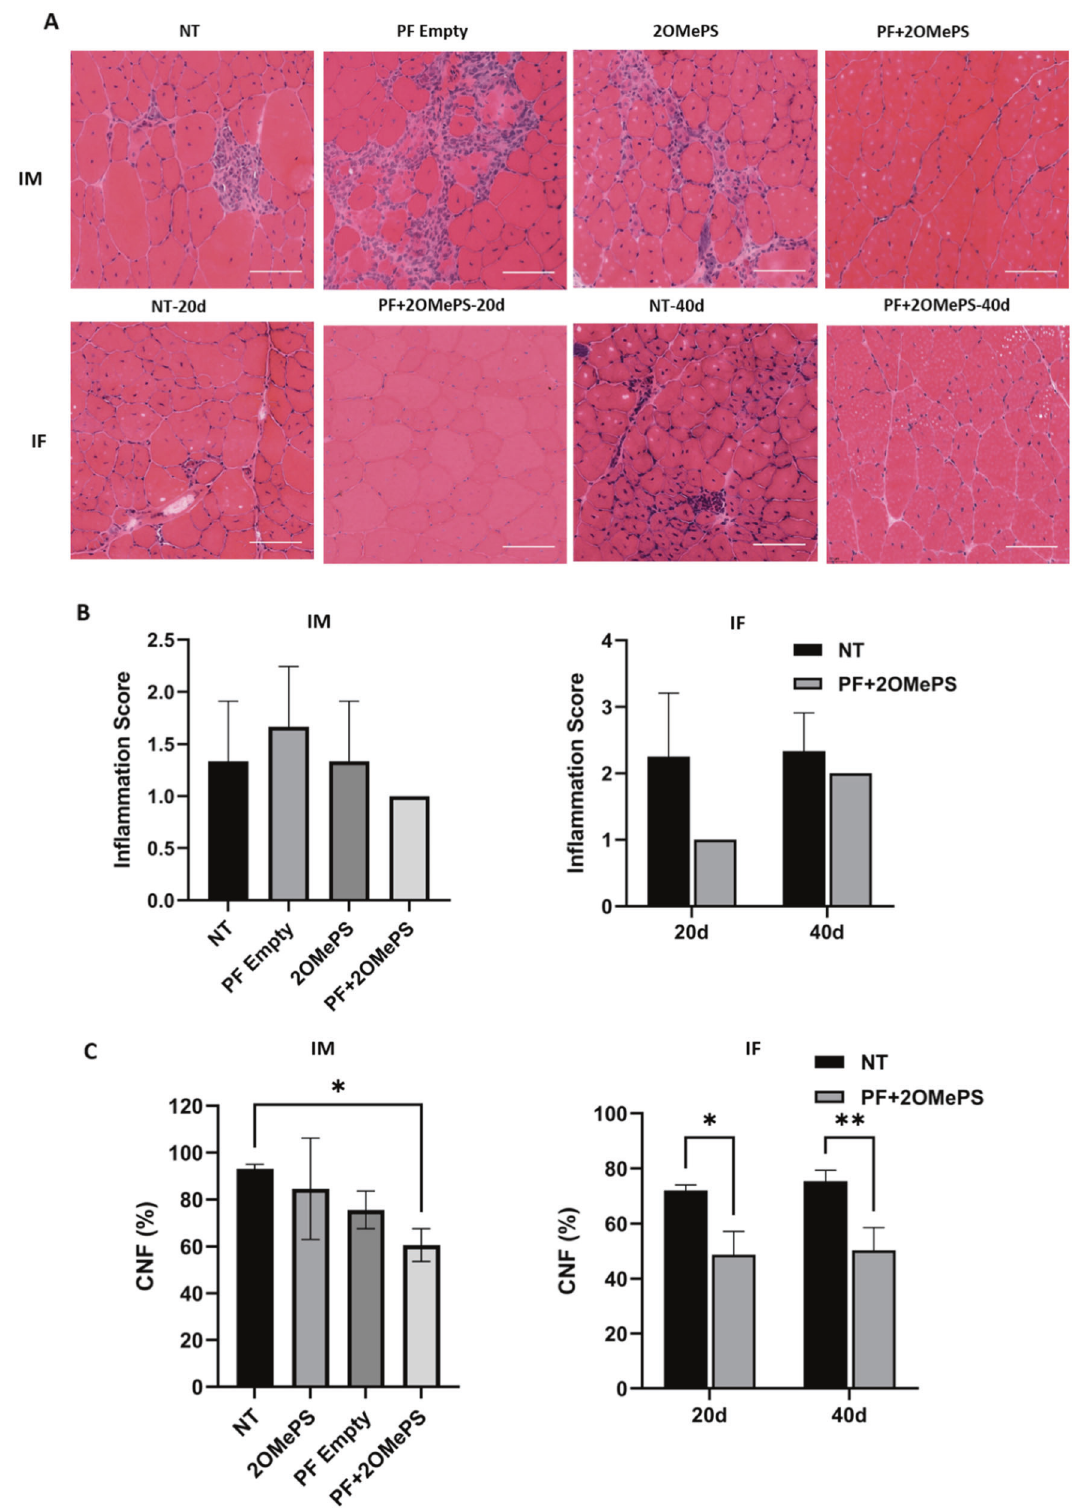
the mildest in fl ammation found in these tissues, whereas the NT mice exhibited a moderate in fl ammation at the same timepoint. Another unexpected outcome of the histopathology was observed at 40 days post-injection when there was only a slight improvement in the muscle ’ s in fl ammation compared to 20